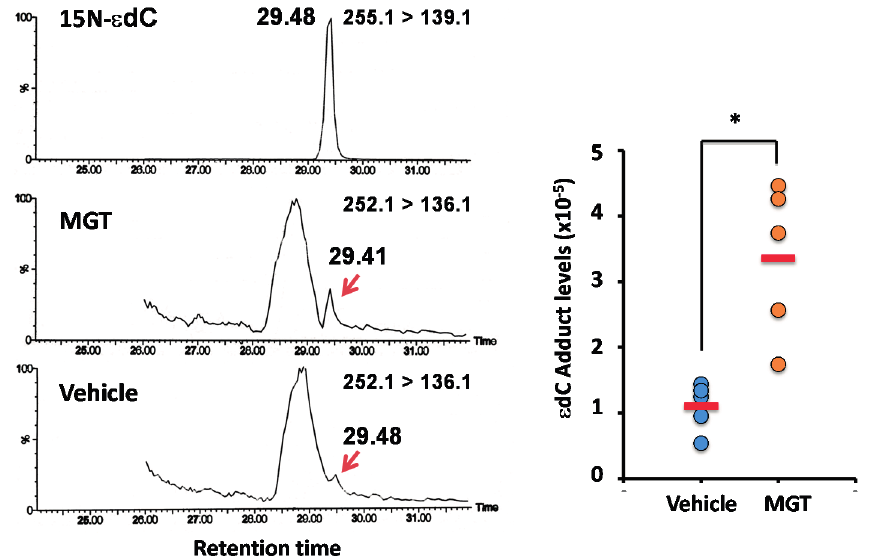
Figure 4. Quantitative Analysis of ε dC by LC-MS/MS. ε dC formation was induced by MGT exposure in the lungs of ICR mice. DNA was extracted from the lungs 24 h after intratracheal instillation of 0.2 mg per animal of MGT, and was digested enzymatically. Control samples were obtained from the lungs of mice given the vehicle for the same durations of MGT exposure. ε dC were quantified by stable isotope dilution liquid chromatography-mass spectrometry (LC-MS/MS). Asterisk (*) indicates a significant difference ( p < 0.05) from vehicle control (treatment with 0.05% ( v / v ) Tween-80) in the Student’s t